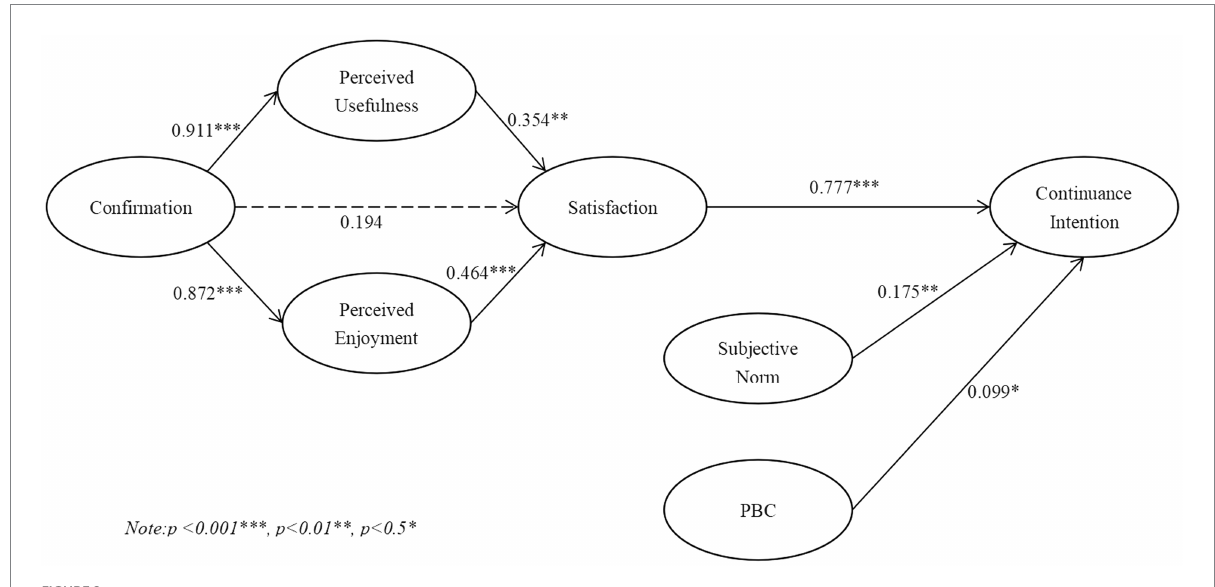
FIGURE 2 SEM results of the research